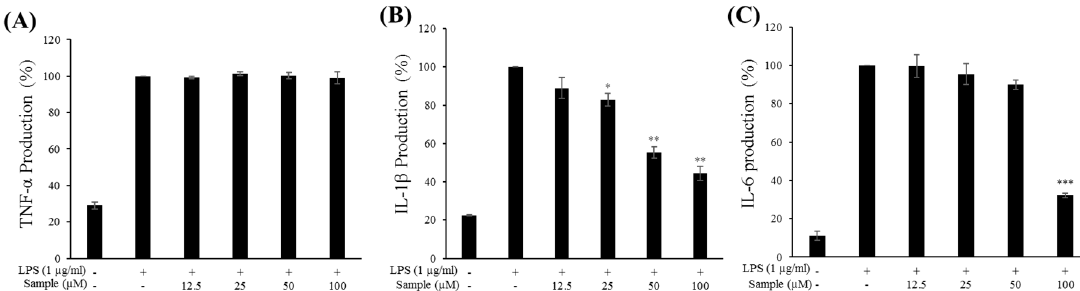
Figure 4. E ff ect of FMP on ( A ) tumor necrosis factor- α (TNF- α ), ( B ) interleukin-1 β (IL-1 β ), and ( C ) interleukin-6 (IL-6) production in LPS-stimulated RAW 264.7 cells. Cells were stimulated with 1 µ g / mL of LPS only or with LPS plus varying concentrations (12.5, 25, 50, and 100 µ g / mL) of FMP for 24 h. Protein production was determined through an ELISA. The data represent the mean ± SD of triplicate experiments. * p < 0.05, ** p < 0.01, *** p < 0.005 versus LPS alone.